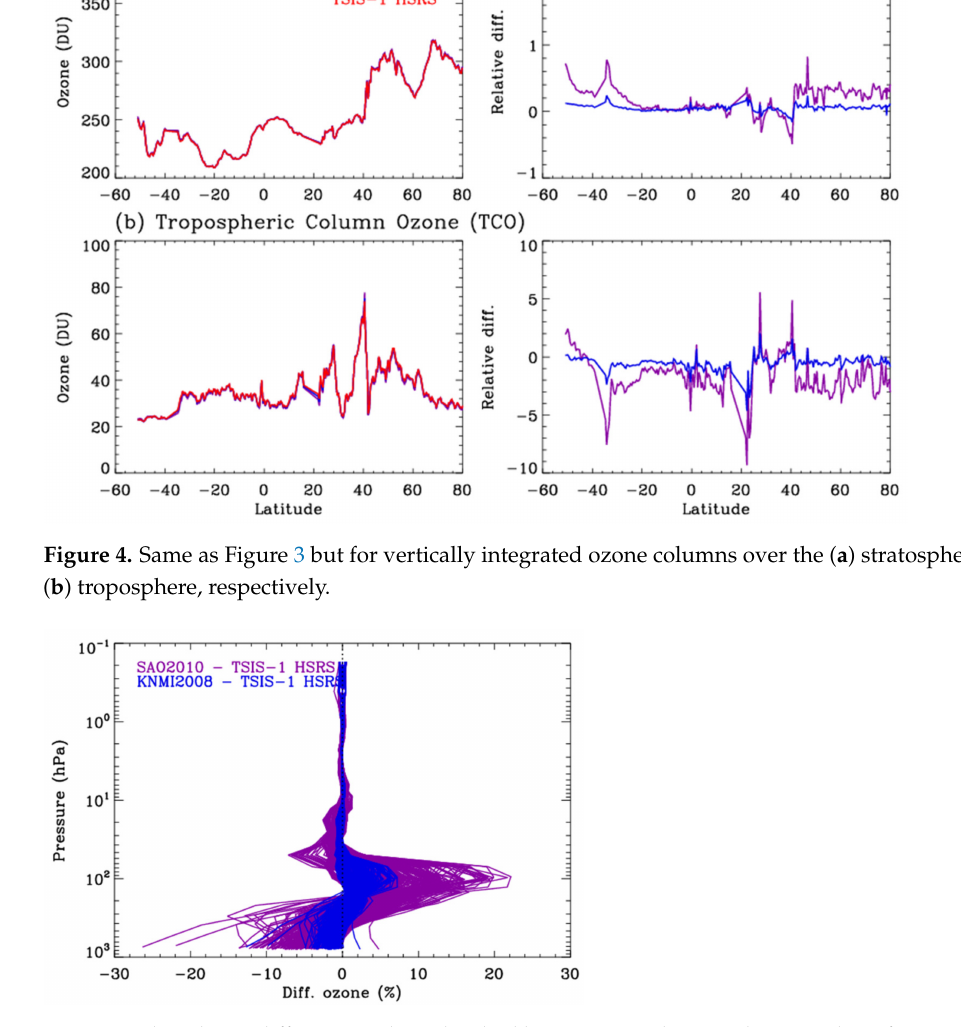
Figure 5. The relative difference in the individual layer ozone columns when switching from SAO2010 or KNMI2008 to the TSIS-1 HSRS. Note that the ozone profiles were retrieved from one orbit mea- surement used in Figures 3 and